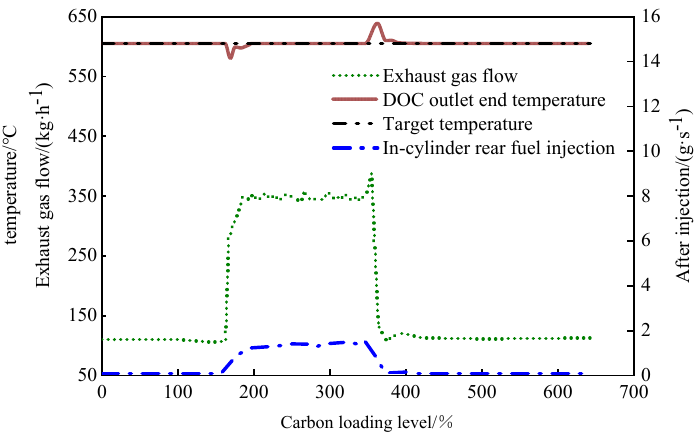
Figure 16. Simulation results under sudden change of exhaust flow.